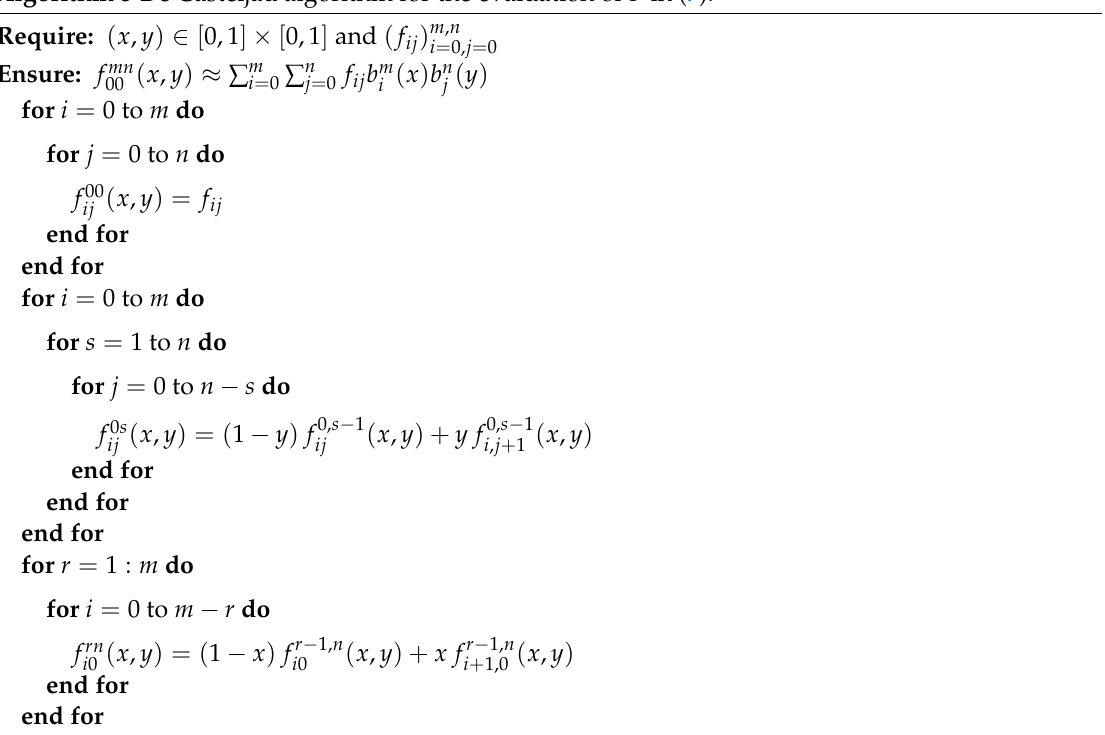
Algorithm 5 De Casteljau algorithm for the evaluation of F in